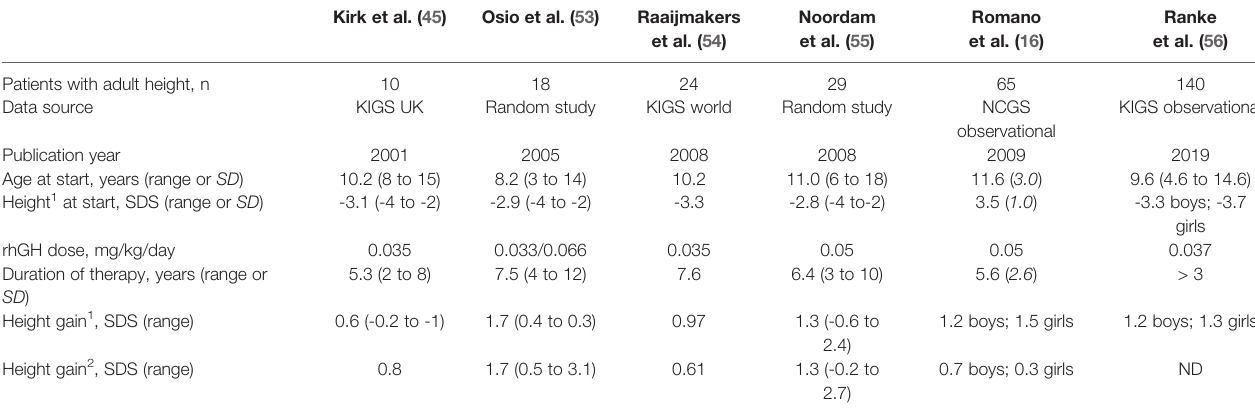
TABLE 2 | Published adult height data in patients with Noonan syndrome treated with rhGH.